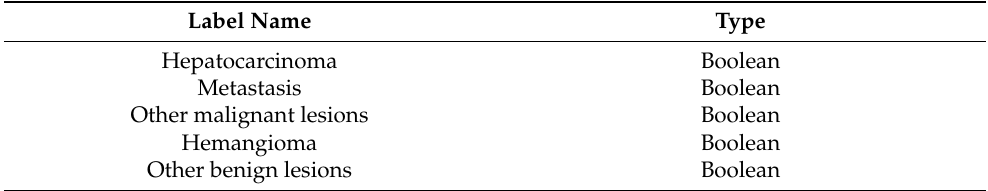
Table 5. Dataset labels used for training the feed-forward neural network